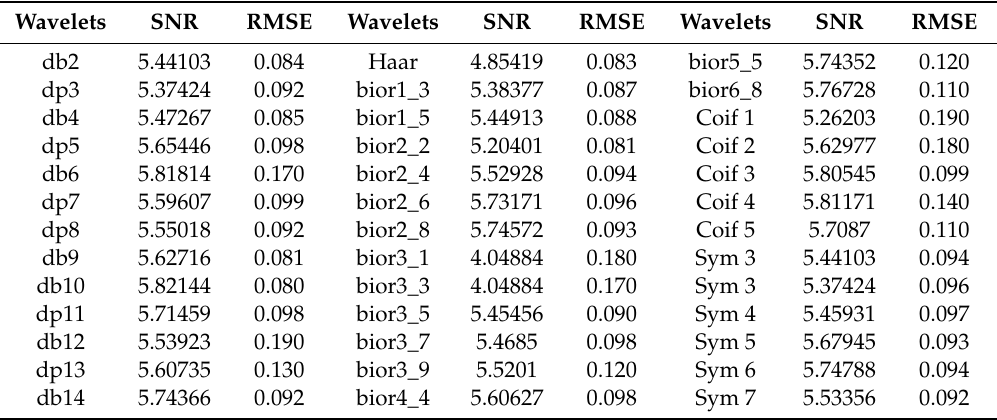
Table 4. The e ff ects of de-noising by di ff erent mother